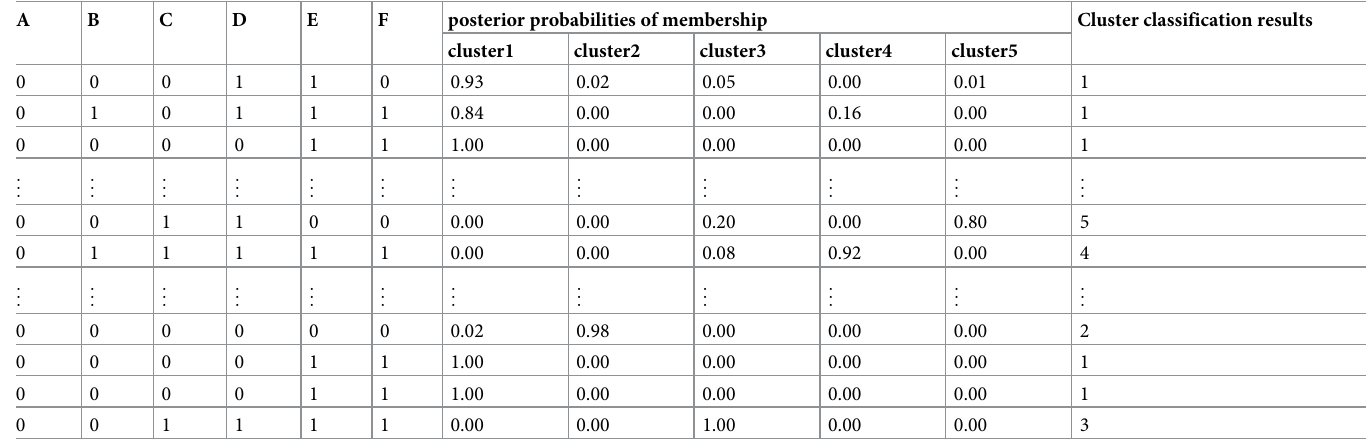
ted models are respectively: Table 4. Posterior probabilities of membership and classification